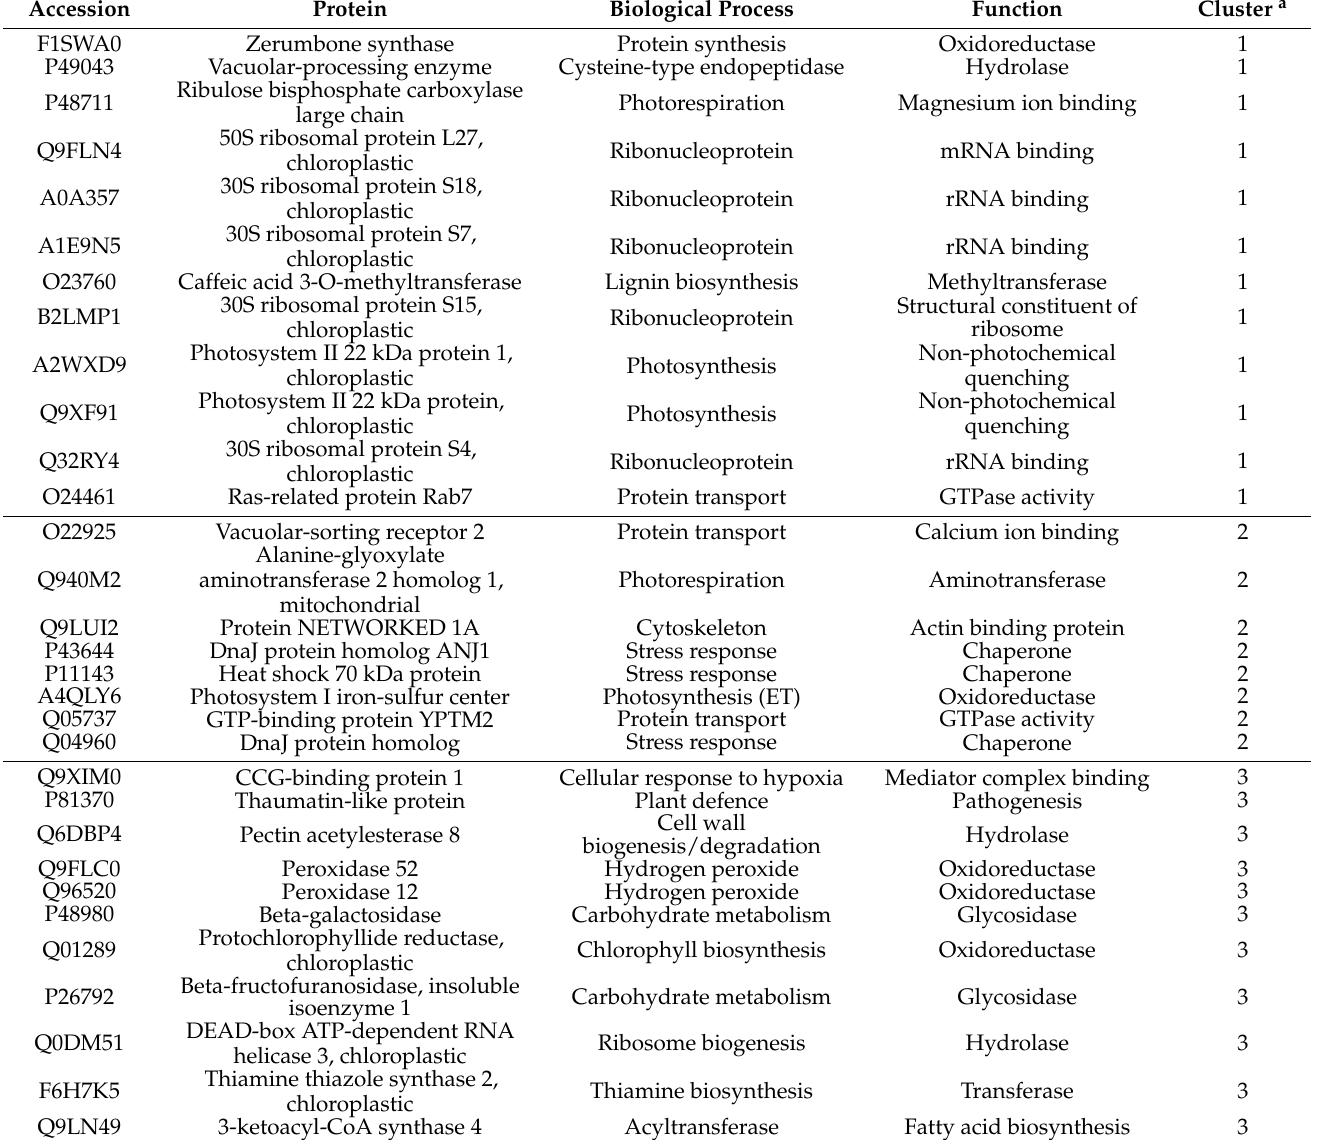
Table 1. List of abundantly altered protein profiles between well-watered, drought-stressed, and recovered Pandanus amaryllifolius